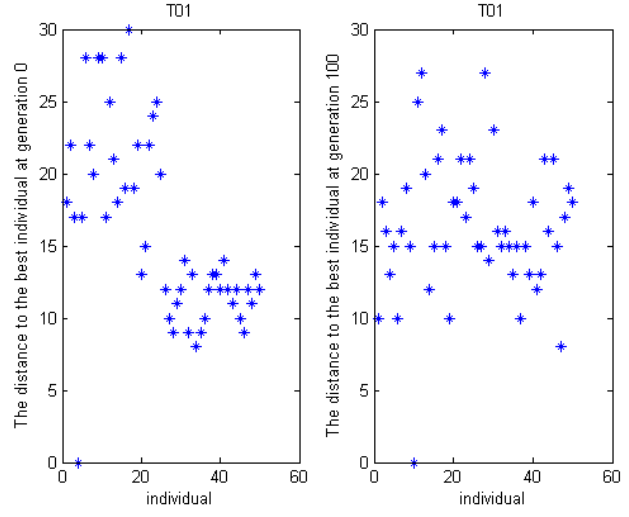
Figure 15. The distance to the best individual for T01.